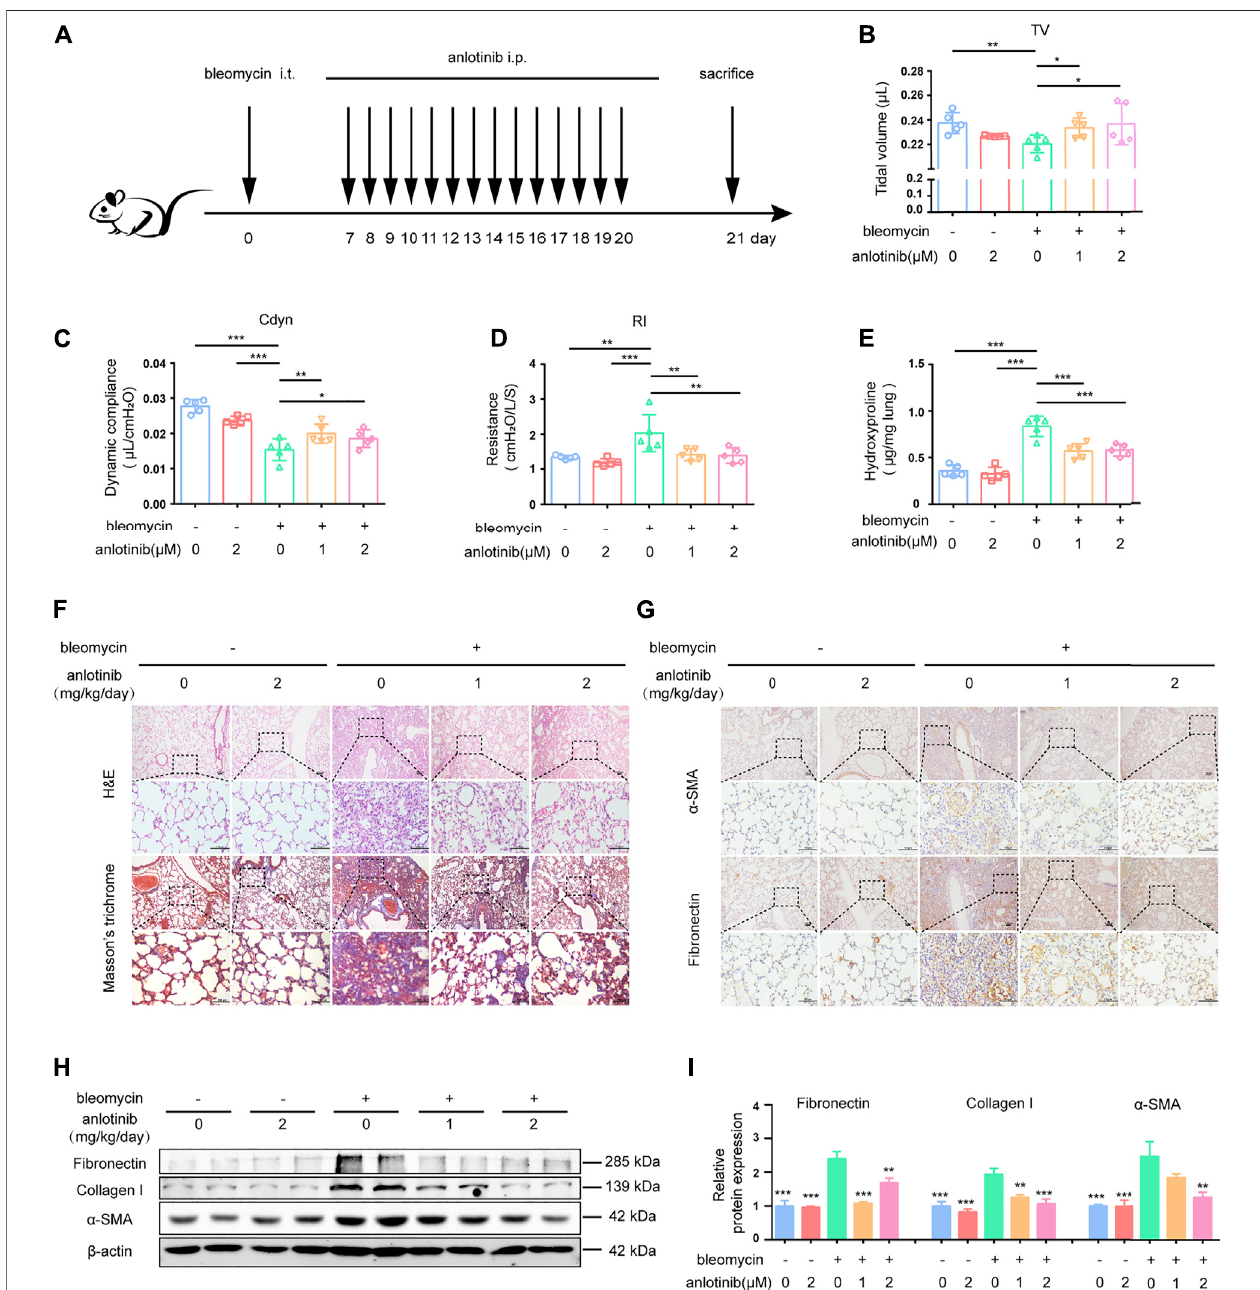
FIGURE7| Anlotinibacceleratesresolutionofbleomycin-inducedpulmonary fi brosis. (A) Interventiondosingregimenofanlotinibinestablishedpulmonary fi brosis. Bleomycininstillationwasusedtoinduce fi brosisandnotreatmentwasgivenduringthe fi rst7 d.Then,micewereintraperitonealyinjuectedwith1or2 mg/kgofanlotinib or vehicle (n (cid:1) 5-6 per group) daily. Lungs were harvested at 21 days. Tidal volume (TV) (B) , dynamic compliance (Cdyn) (C) , and lung resistance (RI) (D) of mice were measured (mean ± SD, n (cid:1) 5). (E) HYP contents in lung tissues from mice (mean ± SD, n (cid:1) 5). Representative images show H&E, Masson ’ s trichrome (F) , α -SMA and Fibronectin staining (G) of lung sections from the indicated groups of mice. Scale bars, 100 µm. (H) Western blot analysis of Fibronectin 、 Collagen I and α -SMA, β -actin was used as a loading control (n (cid:1) 4). (I) Quanti fi cation of Fibronectin 、 Collagen I and α -SMA protein levels relative to β -actin is shown (mean ± SD, n (cid:1) 5). * p < 0.05, ** p < 0.01, *** p < 0.001 VS BLM-treated group by one-way